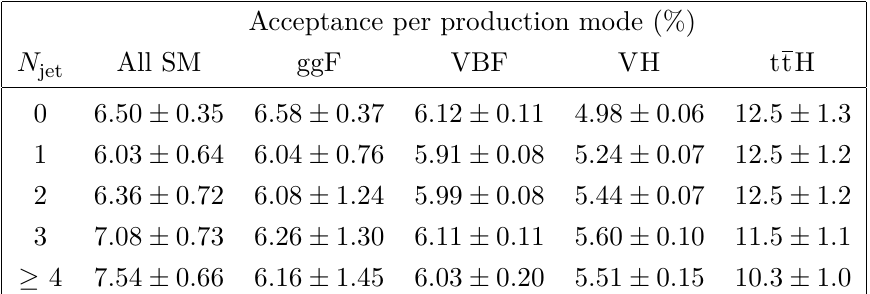
Table 4 . Acceptance of each GL N